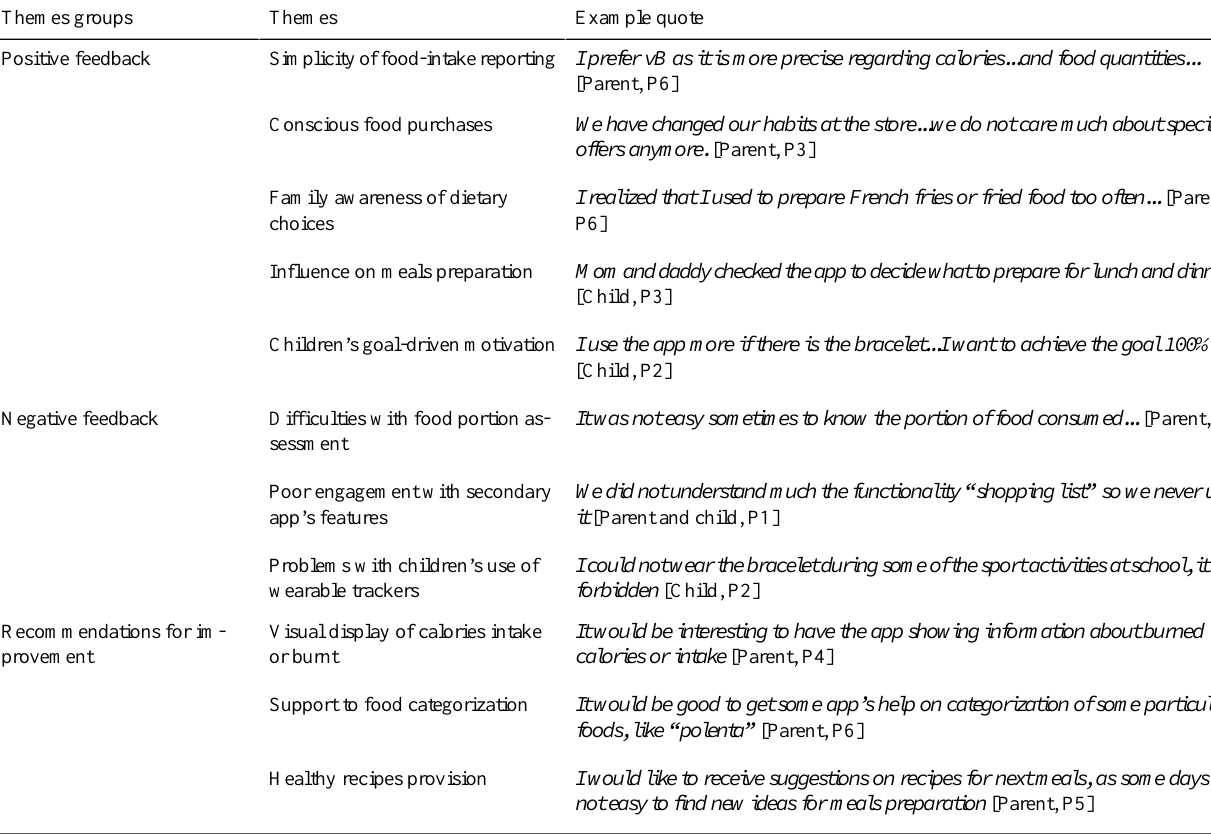
Table 3. List of core themes and relative example quotes derived from the qualitative analysis of participants’post-intervention interviews.